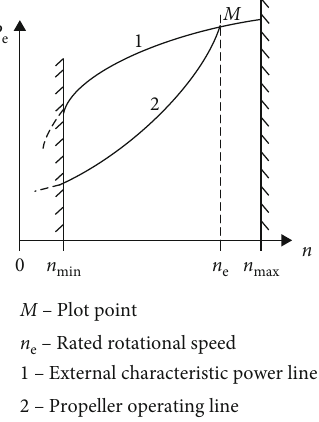
Figure 5: Schematic diagram of the engine-level safe working area and its safety boundaries.